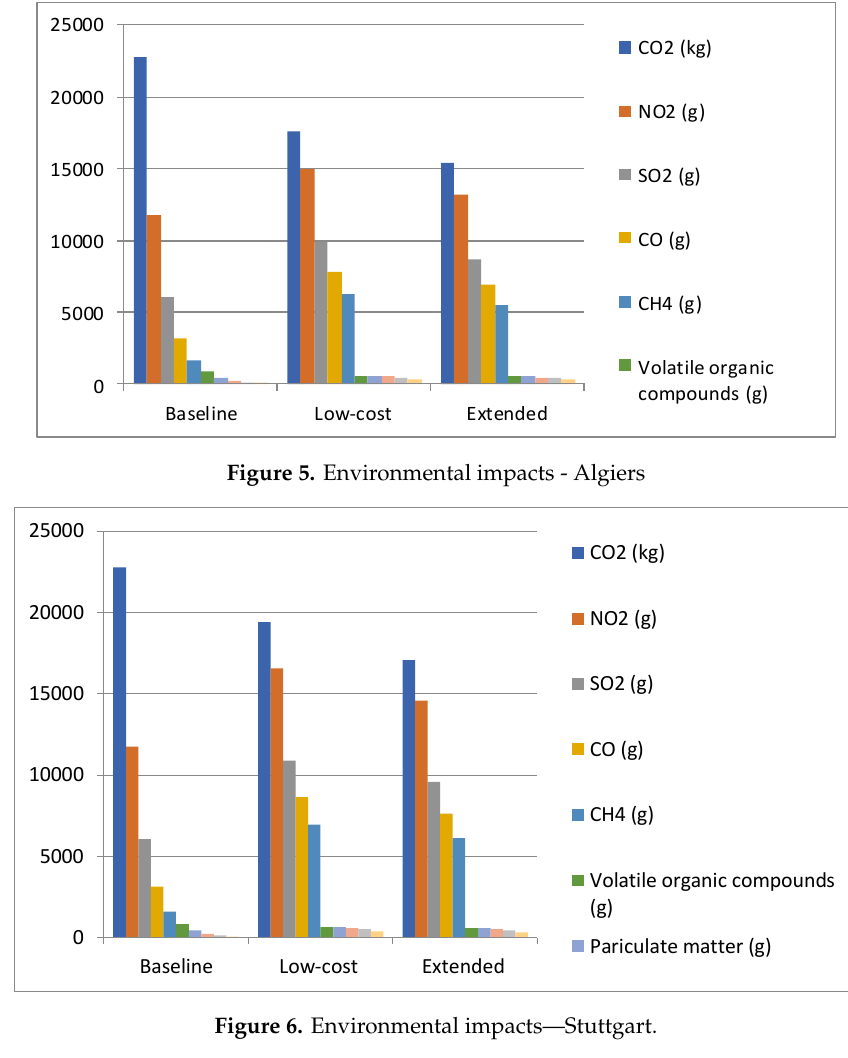
Figure 6. Environmental impacts—Stuttgart.